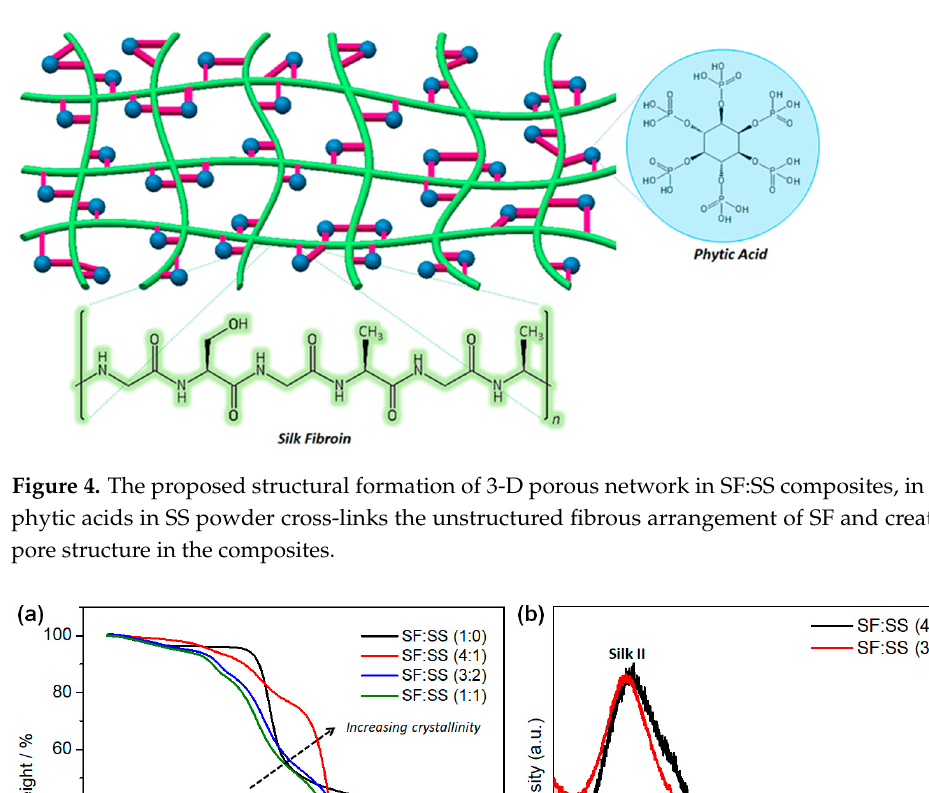
Figure 4. The proposed structural formation of 3-D porous network in SF:SS composites, in which phytic acids in SS powder cross-links the unstructured fibrous arrangement of SF and creates the pore structure in the composites.